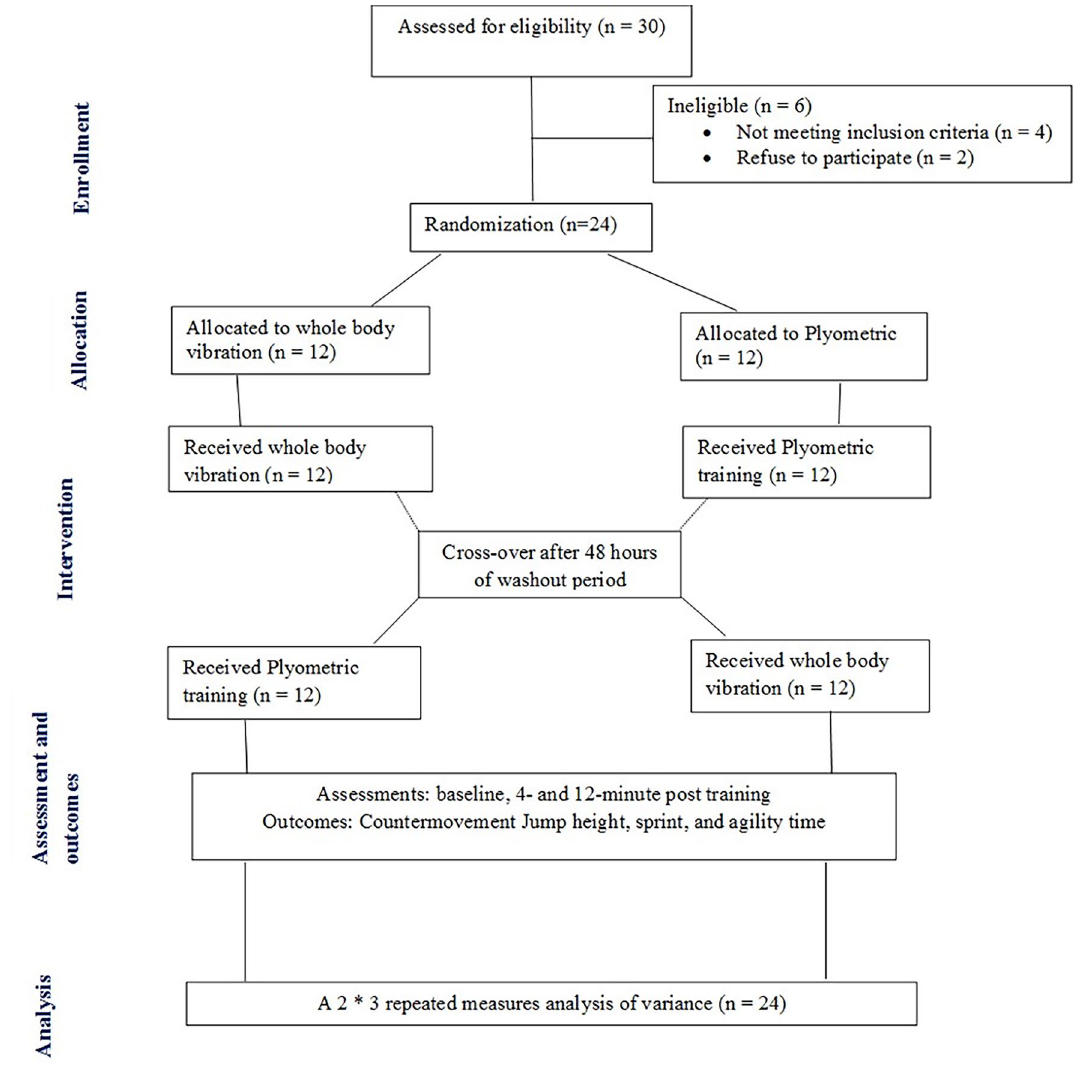
Figure 1. Flow diagram of participants through each stage of the randomized